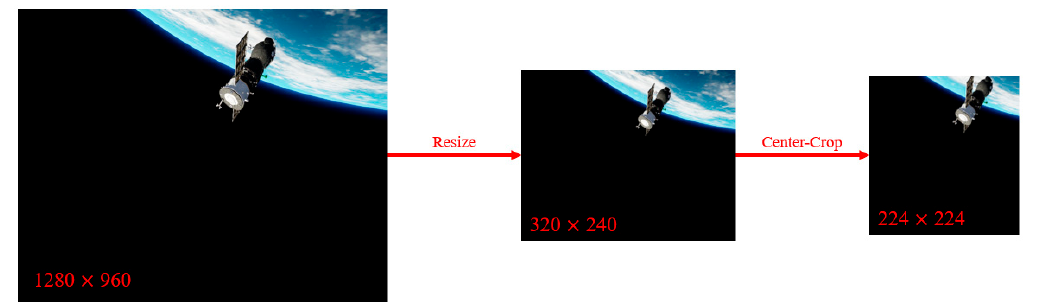
Figure 5. Resizing the image to fit the study format.